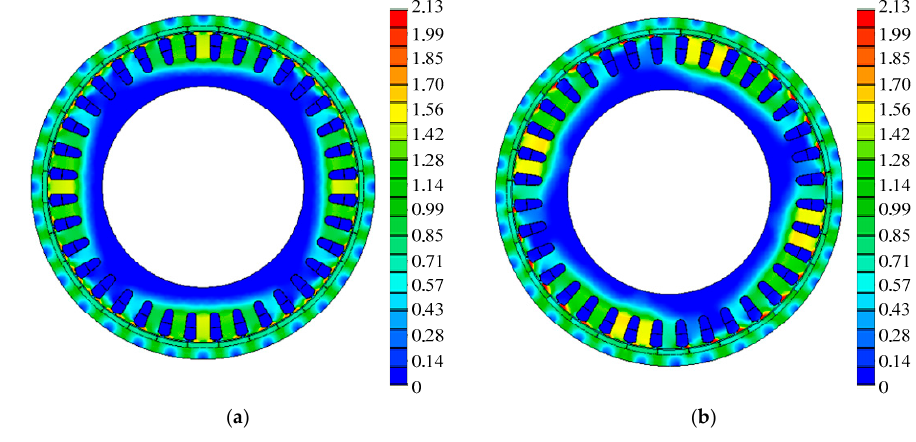
Figure 9. Flux density distribution. ( a ) No-load; ( b ) Load.